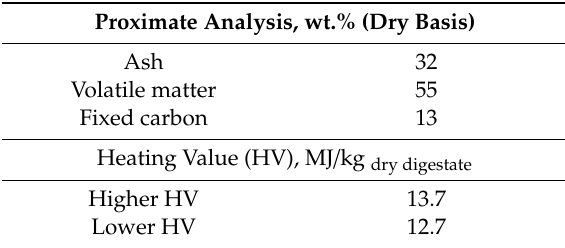
Table 1. Chemical and physical analyses of digestate pellets. Data from Reference [44].